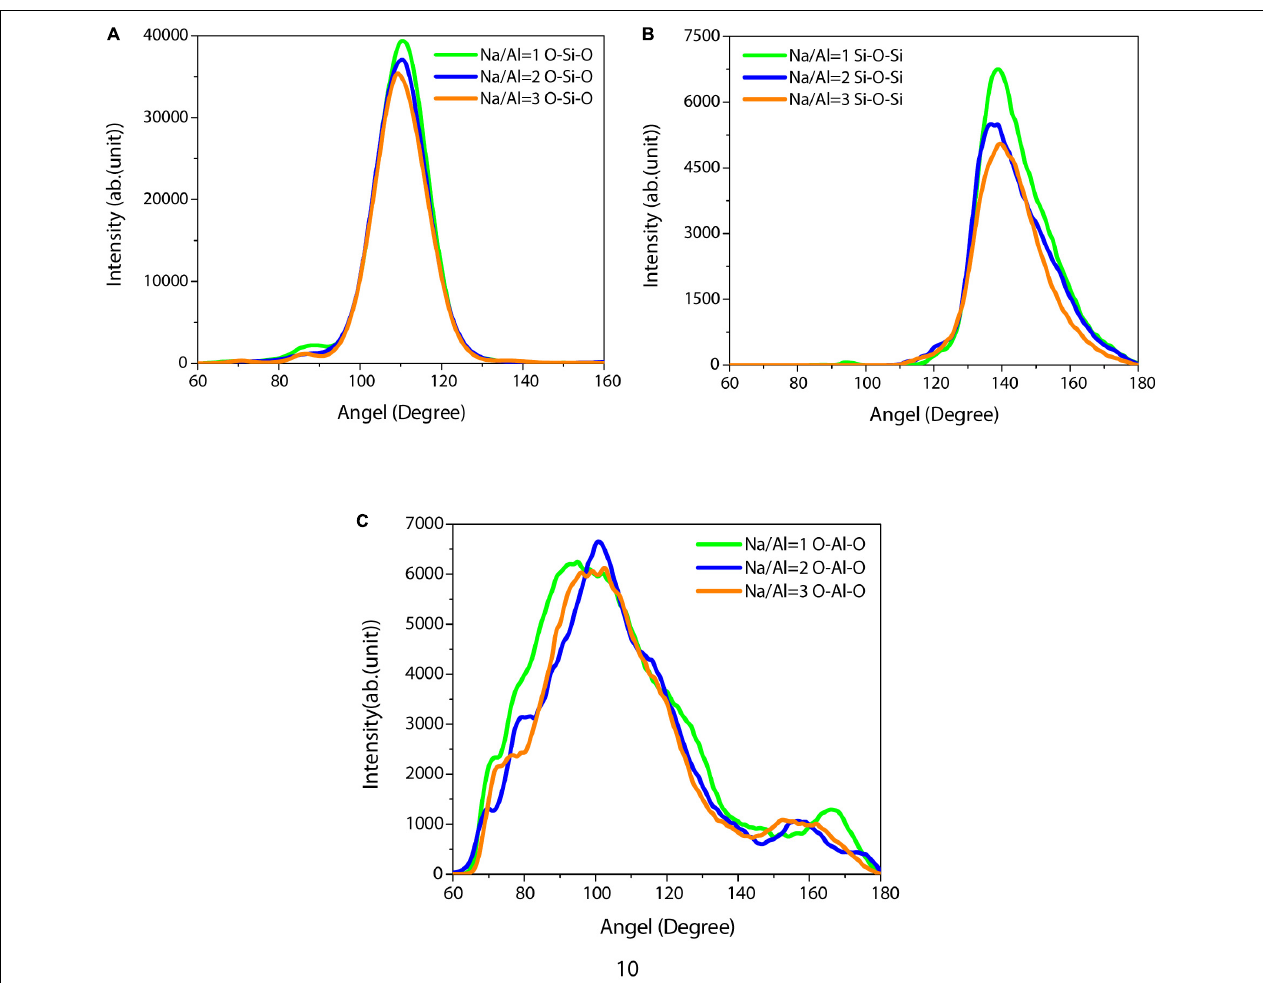
FIGURE 3 | (A) O-Si-O, (B) Si-O-Si, and (C) O-Al-O angle distribution of the NASH gel with a Na/Al ratio of 1, 2, and 3.